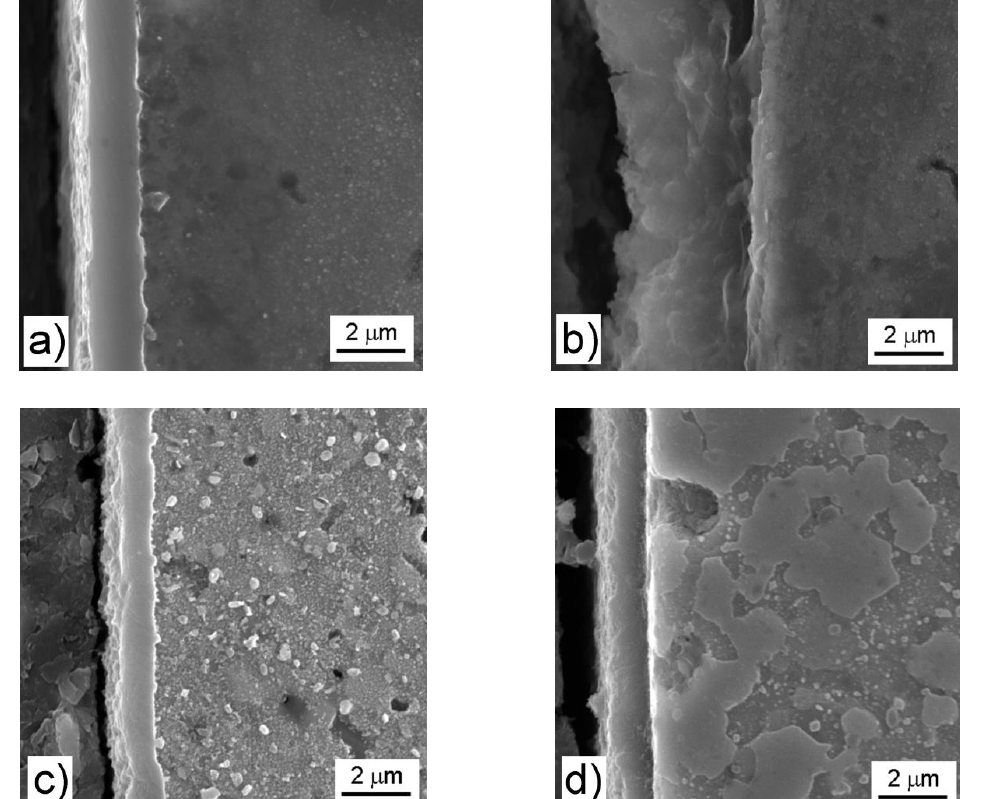
Figure 5. Microstructure of the oxide layers after 300 h of oxidation on ( a ) FeAl32, ( b ) FeSi14, ( c ) FeAl35Si5, ( d ) FeAl20Si20.